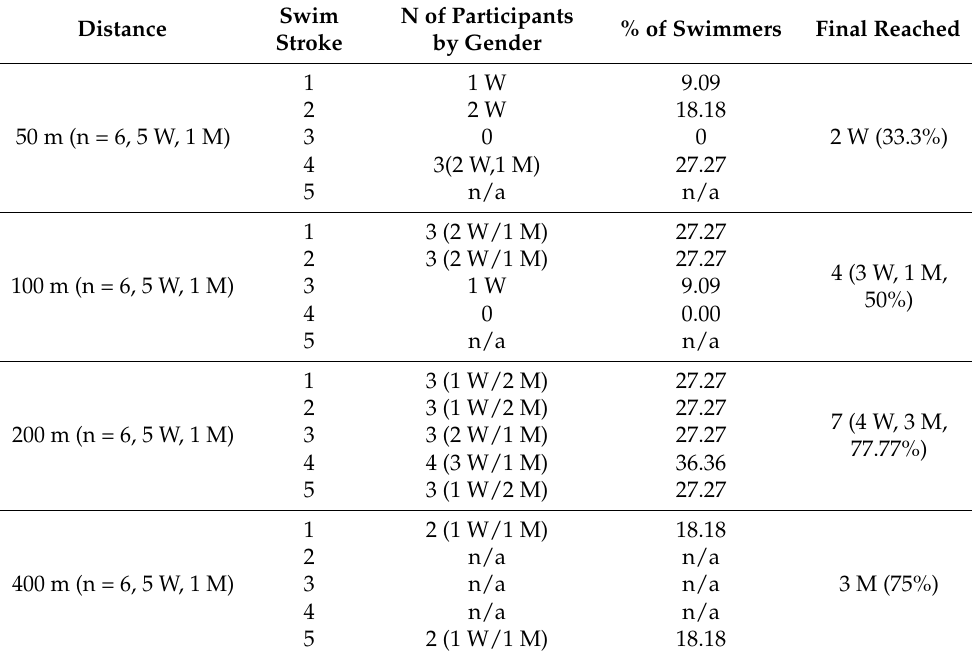
Table 1. Characterization of C3 British swimmers by distance and swim stroke.